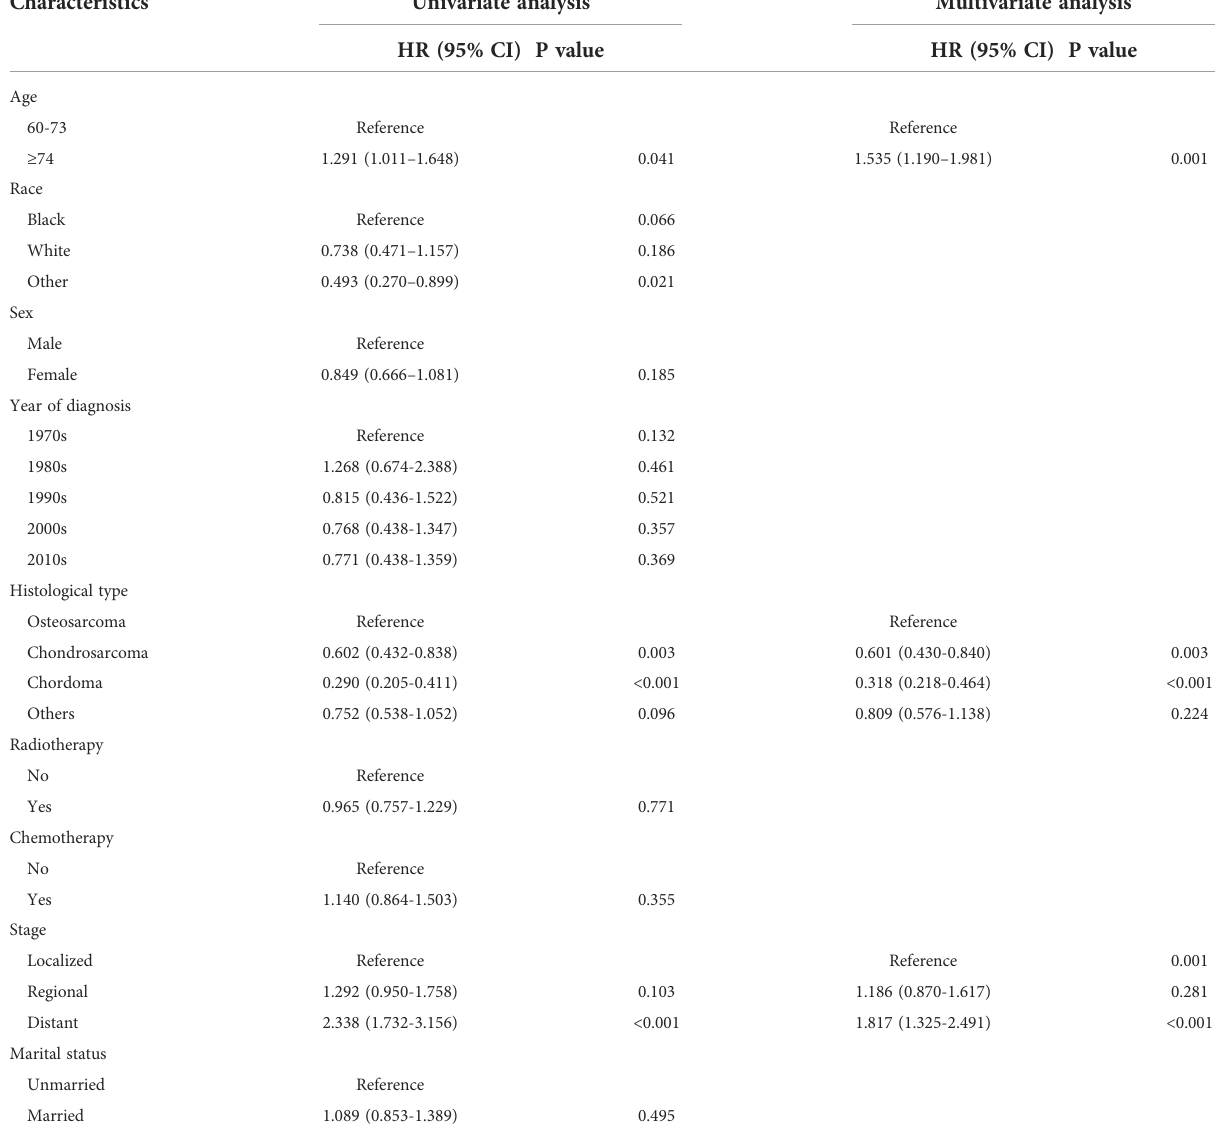
TABLE 2 Analysis of univariate and multivariate Cox regression in elderly patients with primary spinal tumors who have not undergone surgical treatment.